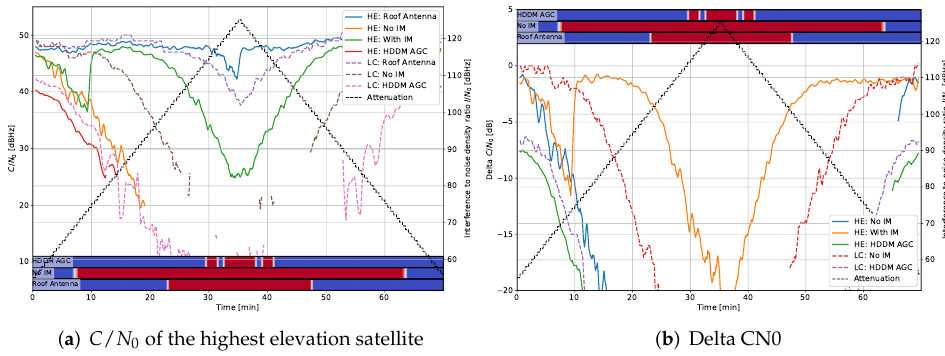
Figure A10. Interference #1: CW 1 575.42 MHz with Galileo E1BC.